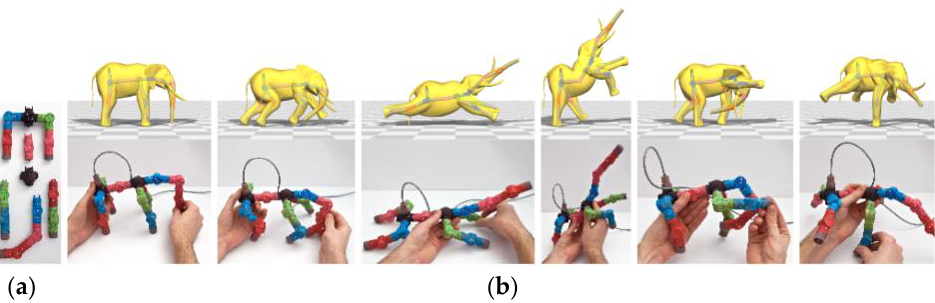
Figure 33. Modular, interchangeable parts for construction skeleton of elephant ( a ), manipulates with elephant ( b ) [57].